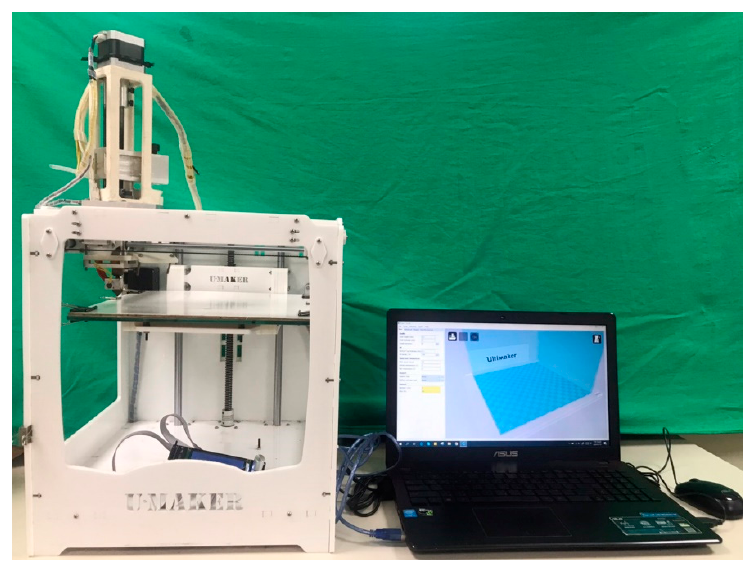
Figure 1. Photo of the solution extrusion additive manufacturing device, which consists of a solution- type plunger-actuated feeding system, stepper motors, motion components, a power supply unit, an accumulation platform, and a user interface with connectivity.